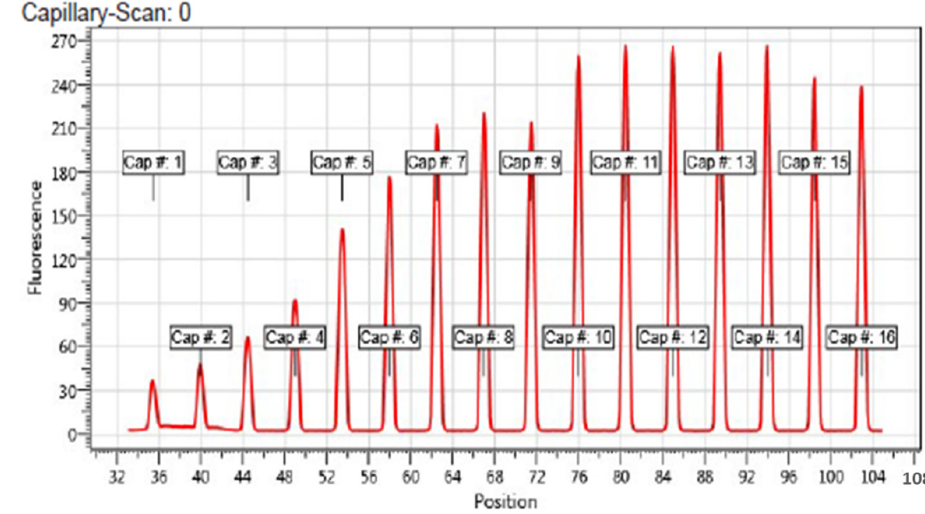
Figure 6. Capillary scan of all 16 capillaries containing TET1 protein and with and without compound 1 . Cap #. 1 contain highest amount of compound 1 and the following caps. 2–16 are sorted according to its concentration, in descending order. Capillary position is labeled in the figure.